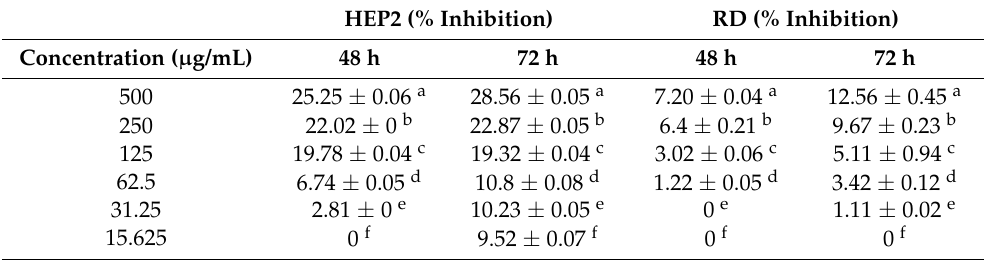
Table 7. The EamCE percentage inhibition of HEP2 and RD cell